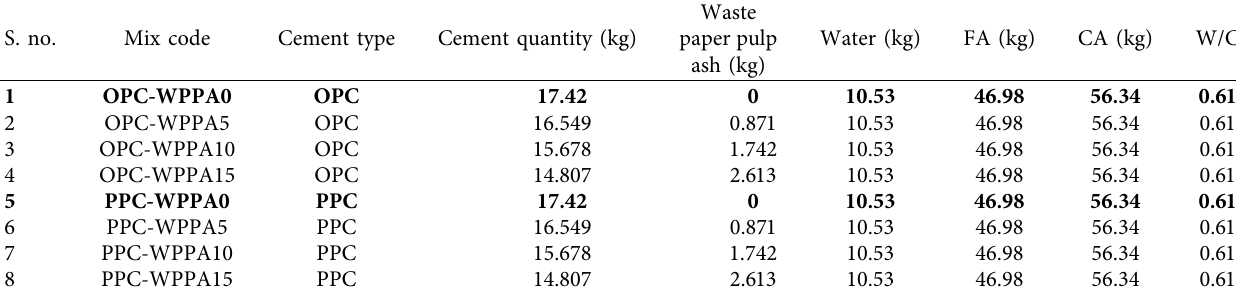
Table 7: Mix Proportions for OPC-WPPA and PPC-WPPA of C-25 concretes. S. no.